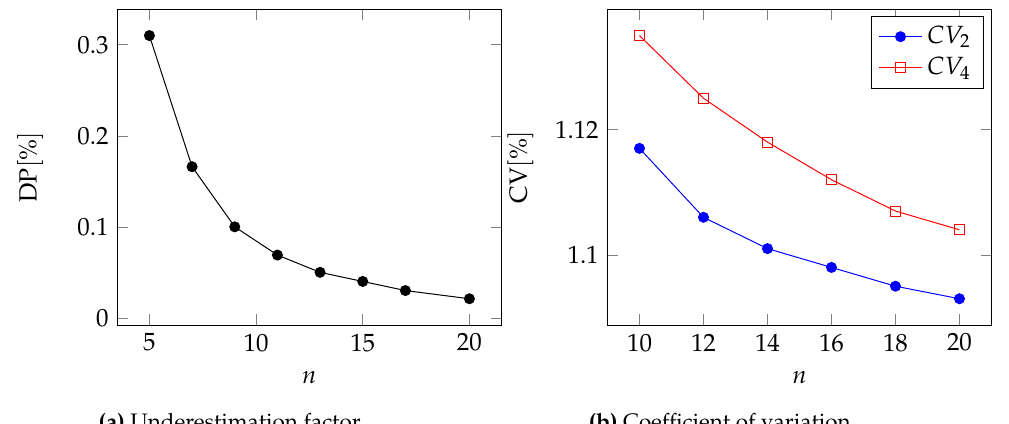
Figure 3. Performance metrics for the GPD case (distribution parameters as in Table 5)